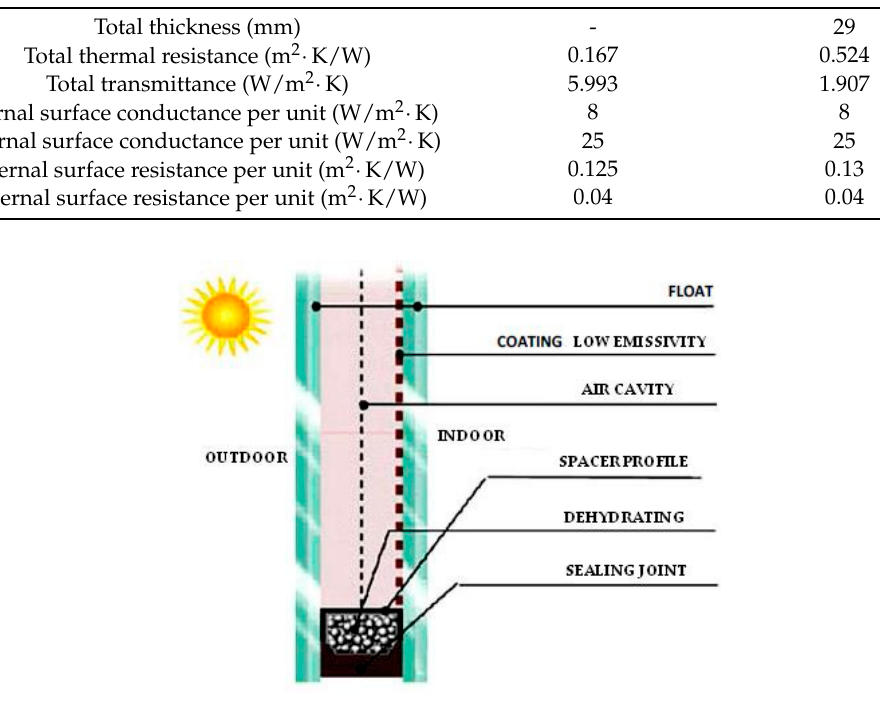
Table 8. MiSE fixtures thermal performance before and after intervention. Table 7. MiSe fixtures stratigraphy before (single glasses) and after (low-e glasses) intervention.